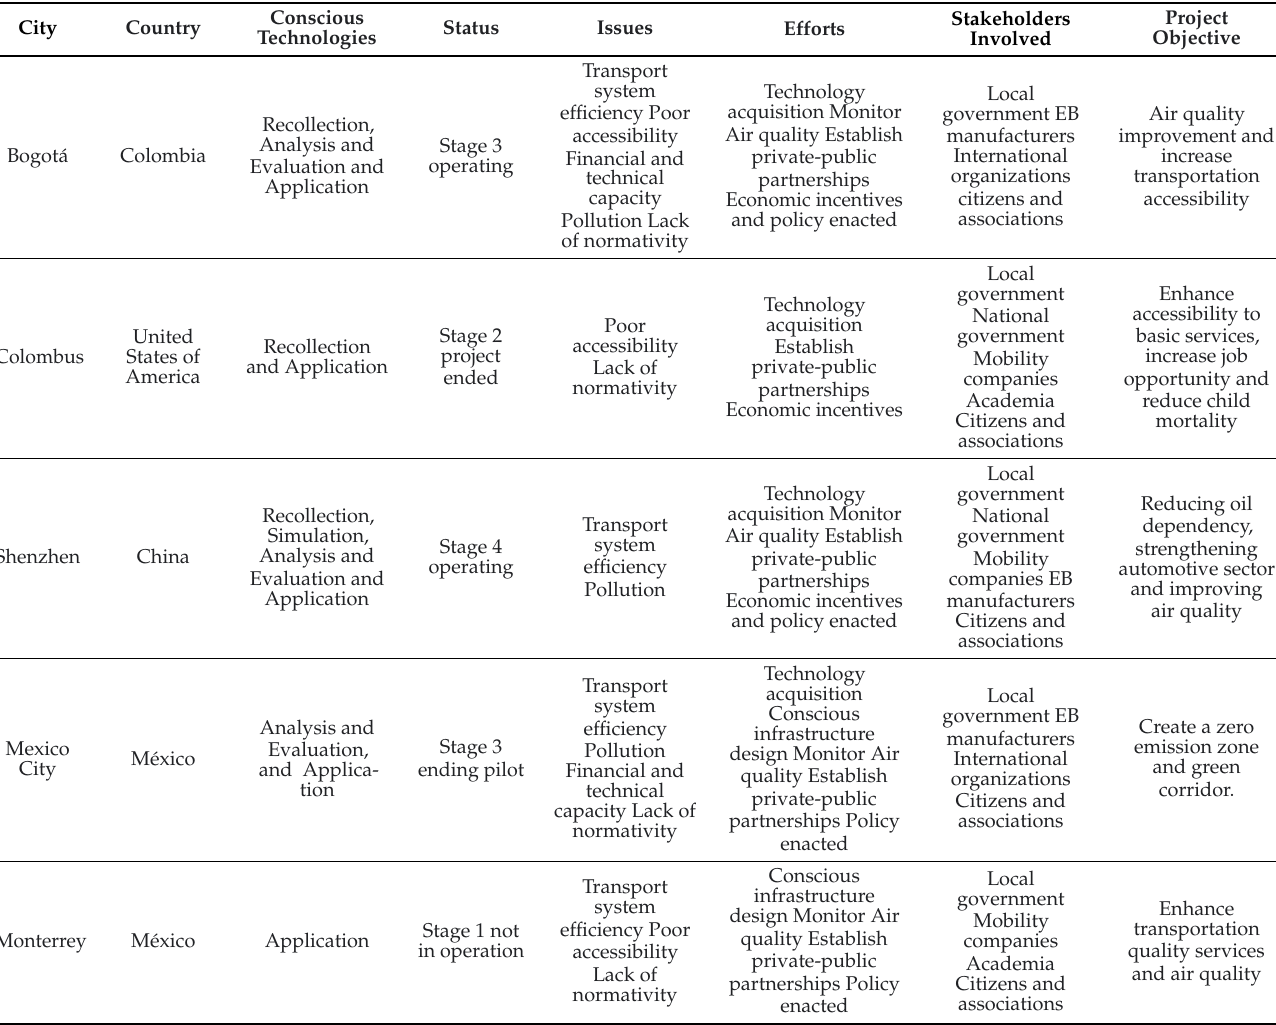
Table A1. Conscious mobility case studies matrix